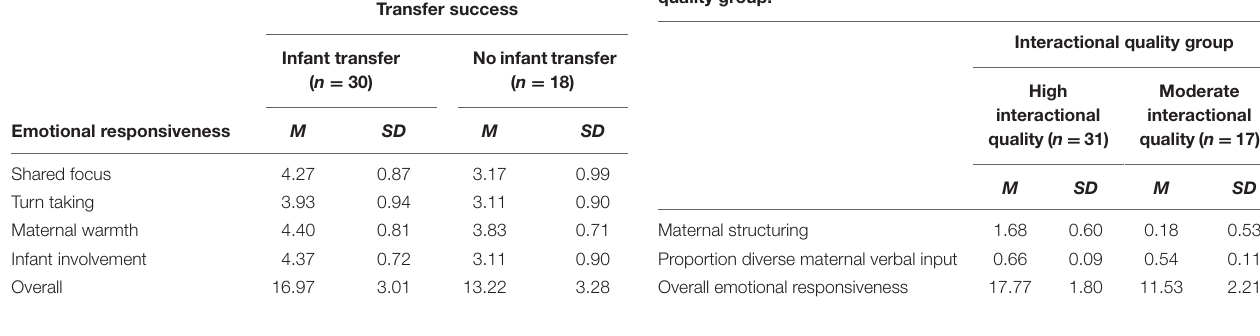
TABLE 3 | Maternal structuring, proportion of diverse maternal verbal input and overall emotional responsiveness as a function of interactional quality